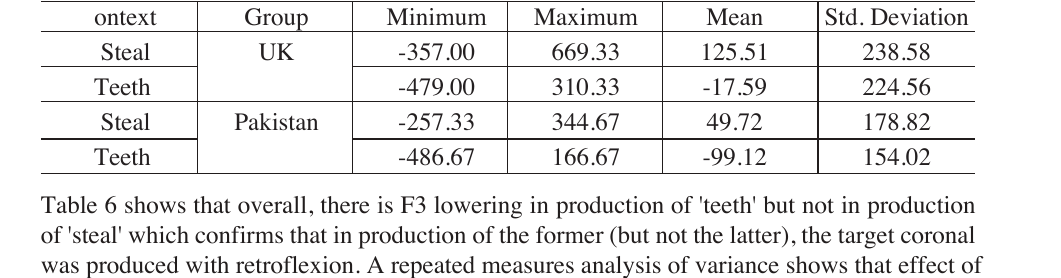
Mean F3 raising/ lowering